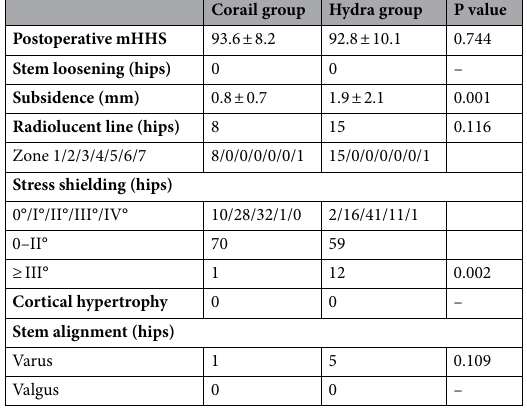
Table 2. Postoperative outcomes. mHHS modified Harris hip score.